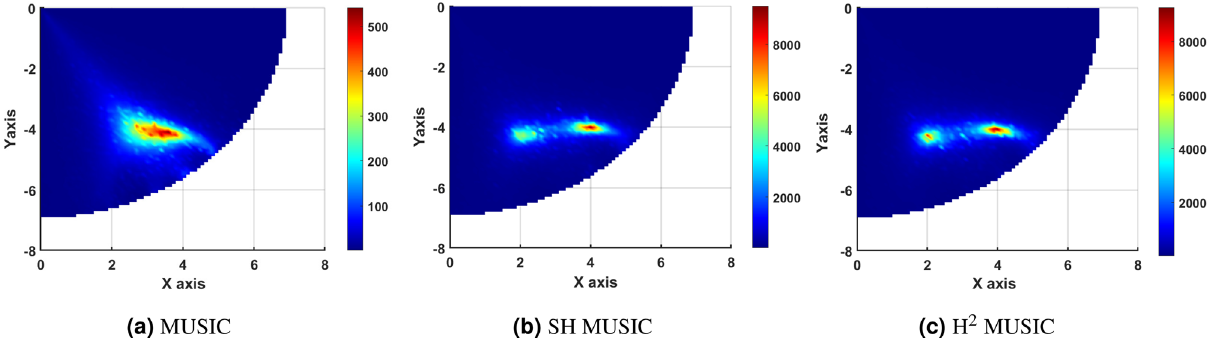
2 MUSIC for two active dipole